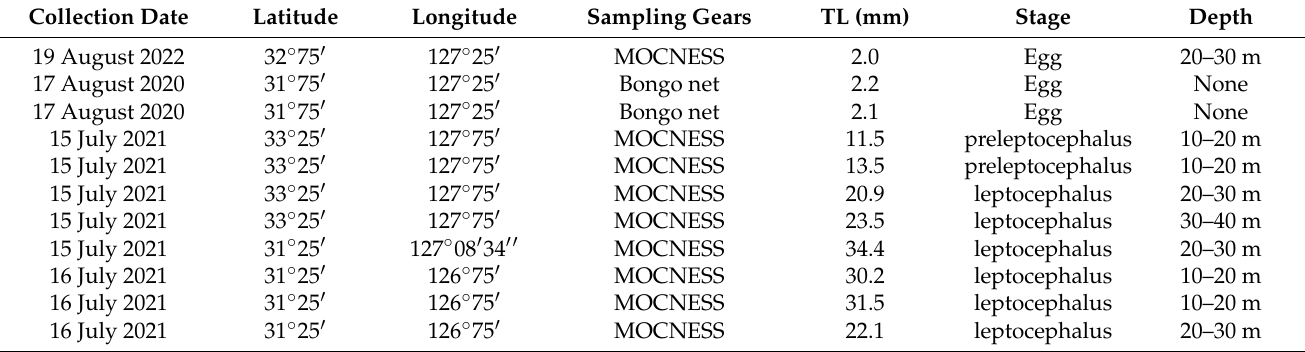
Table 1. List of Muraenesox cinereus eggs and leptocephali collected from offshore of Jeju Island.